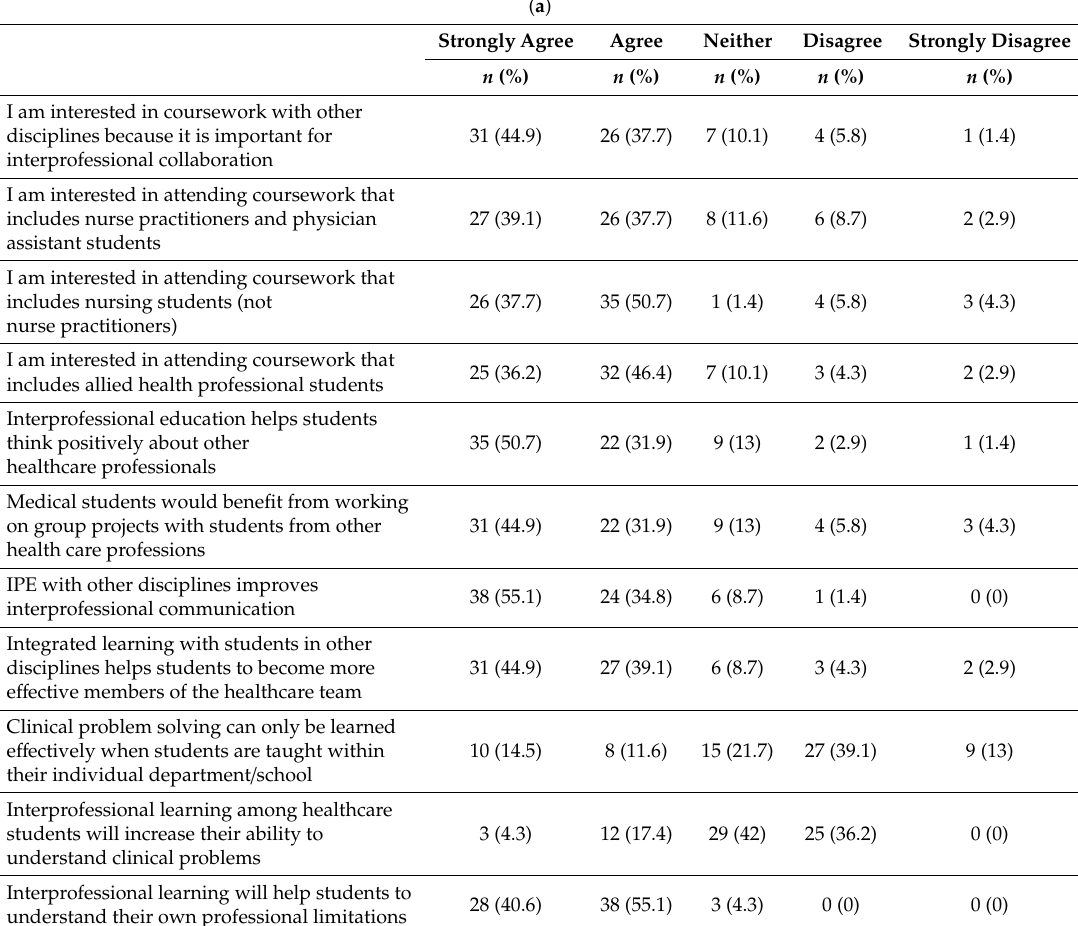
Table2. ( a )AttitudesandperceptionsofmedicalstudentstowardIPEcoursework, n = 69; ( b )Attitudesand perceptions of medical students toward IPC in patient care, n = 69; ( c ) Attitudes toward Interprofessional Collaboration with healthcare team, n =